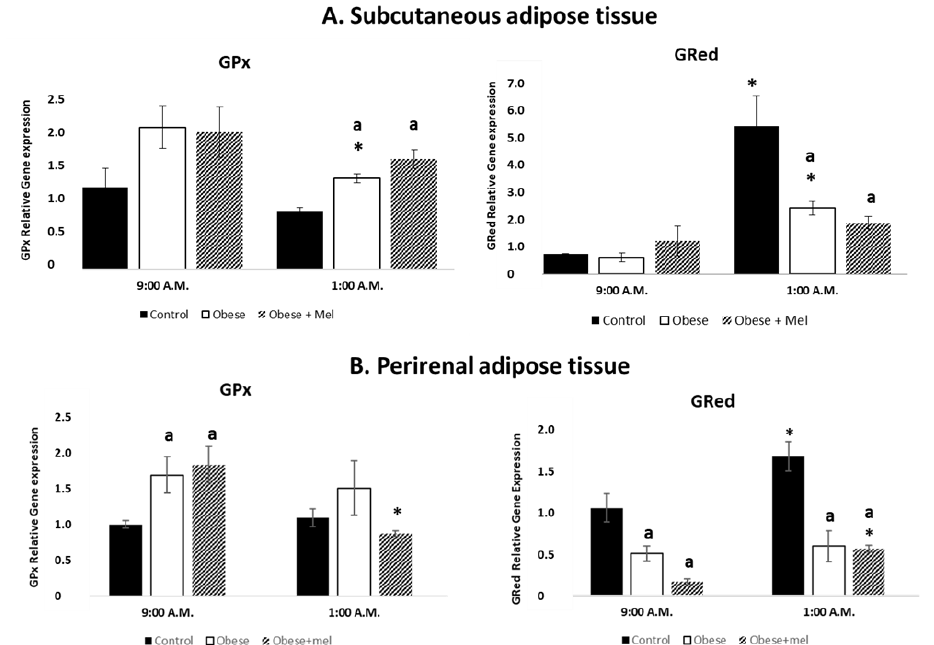
Figure 3. Relative gene expression of GPx and GRed enzymes in subcutaneous ( A ) and perirenal ( B ) adipose tissue of male Wistar rats at two different times (9:00 a.m. and 1:00 a.m.). Each value represents the mean and s.e.m. (n = 5). (A) The letter indicates significant differences between diets (control or high fat diet) at the same schedule ( a p < 0.05 vs. control) and the asterisk (* p < 0.05) indicates significant differences between schedules in each experimental group. (B) The letter indicates significant differences between diets (control or high fat diet) at the same schedule: GPx ( a p < 0.05 vs. control) ; GRed 09h00 a.m. ( a p < 0.05 vs. control) GRed 01:00 a.m. ( a p < 0.001 vs. control). The asterisk indicates significant differences between schedules in each experimental group: GPx (* p < 0.006); Control GRed (* p < 0.05) HFD+Mel (* p < 0.001)